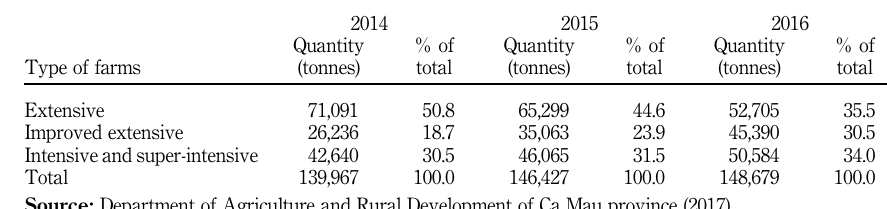
Table II. Production of shrimp in Ca Mau